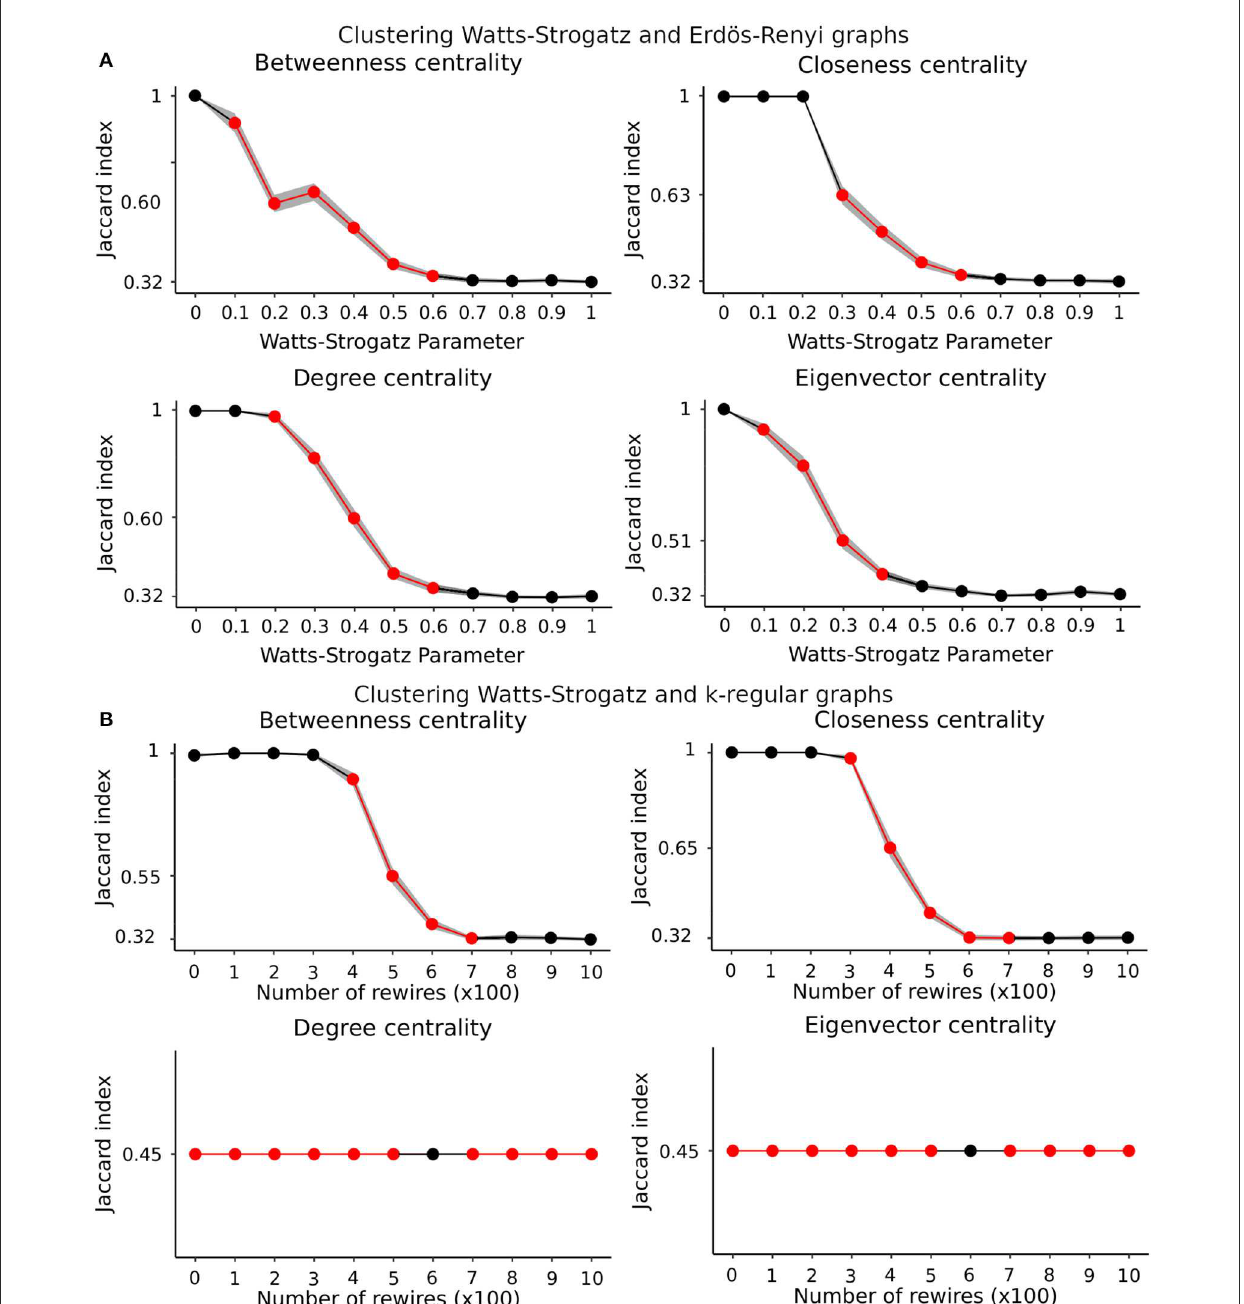
FIGURE4 Results of clustering graphs in simulation 2 using betweenness, closeness, degree, and eigenvector centrality measures. (A) Results of scenario (a). (B) Results of scenario (b). Each point represents the average Jaccard index of 100 runs for both scenarios. The shaded area represents the 95% confidence interval. The Jaccard index of 0.32 corresponds to 50% accuracy. The points in red represent a p -value < 0.05 for the ANOVA after Bonferroni correction for multiple tests. In both scenarios, all centrality measures presented a Jaccard index < 1 for lower Watts-Strogatz parameters and fewer rewires compared to results in Figure